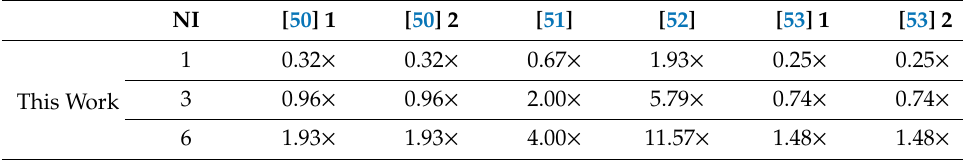
Table 16. Analysis of the ratio occupation for NMULT.